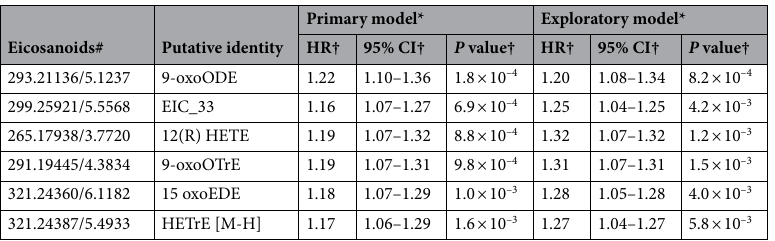
Table 2. Eicosanoids associated with incident AF (FDR < 0.05). # Each eicosanoid is represented by MZ/ RT; MZ is the mass-to-charge ratio (to 5 decimals) and RT is the retention time (to 4 decimals). *Primary model was adjusted for age, sex, height, weight, systolic and diastolic blood pressure, current smoking, use of antihypertensive medication, diabetes, history of myocardial infarction, and history of heart failure; Exploratory model was additionally adjusted for CRP and IL-6 concentration. † HR Hazard ratio expressed per standard deviation of log transformed normalized eicosanoid concentration, CI Confidence interval; P value was not adjusted for multiple